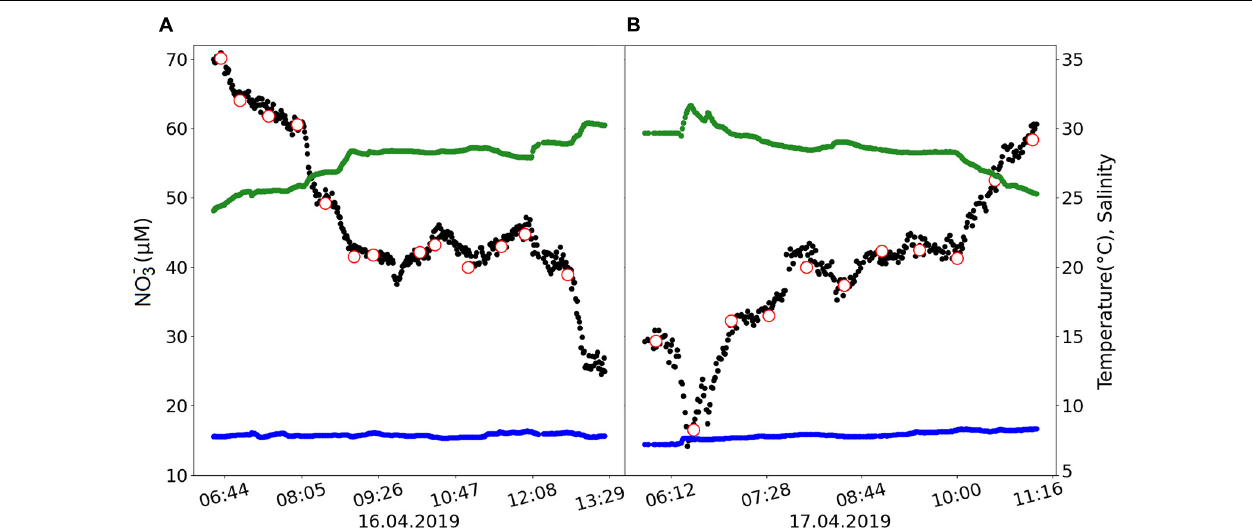
FIGURE 12 | Time series of NO 3 − ( µ M), temperature ( ◦ C), and salinity during the Sternfahrt-1 expedition on (A) the first day sailing from Büsum to Helgoland and (B) the second day sailing from Helgoland to Büsum. Black dots refer to the post-processed OPUS NO 3 − data output, and red circles are the NO 3 − concentrations of the discrete water samples analyzed in the laboratory by a wet-chemical analyzer. Blue and green dots indicate the in situ temperature and salinity of the sample,